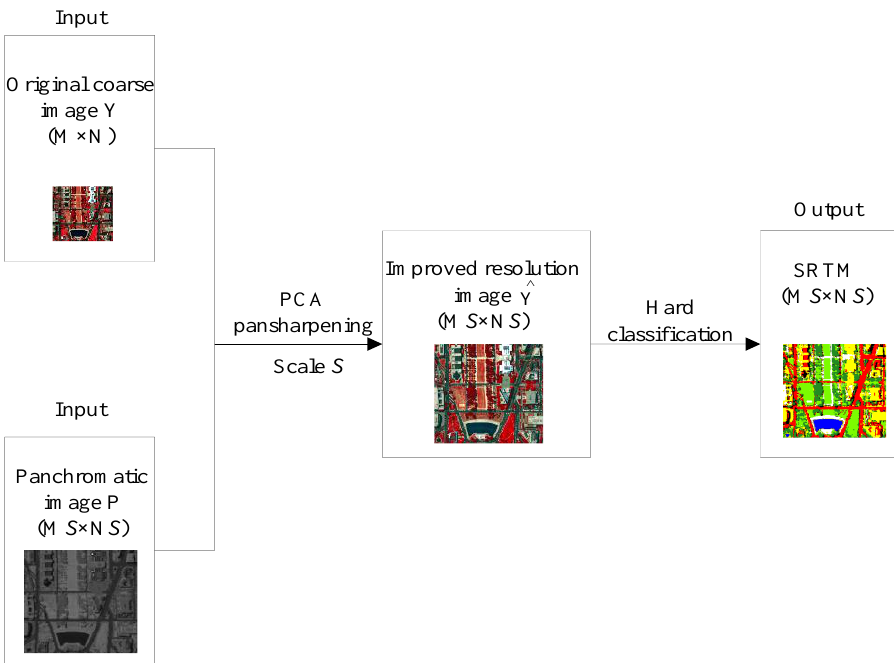
Figure 5. The flowchart of the pansharpening then hard classification (PTC) method.